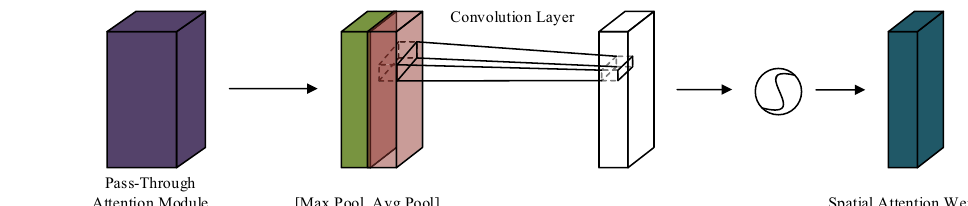
Fig. 5 The spatial attention module